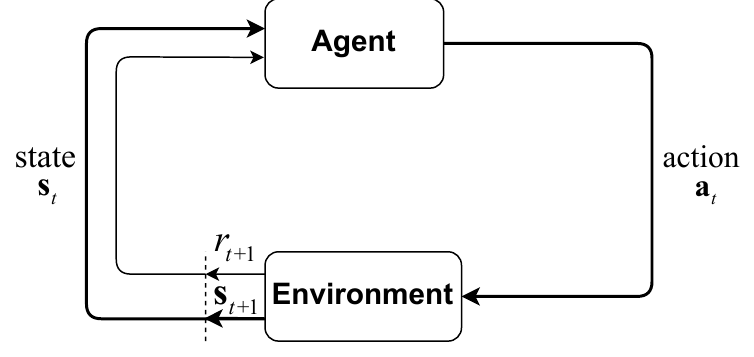
Figure 1. Workflow scheme of the RL